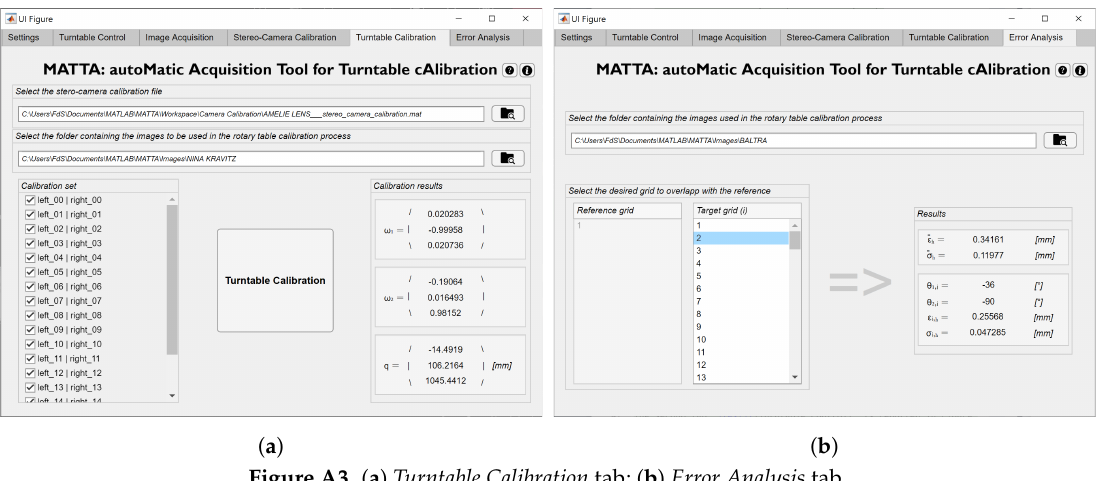
Figure A3. ( a ) Turntable Calibration tab; ( b ) Error Analysis